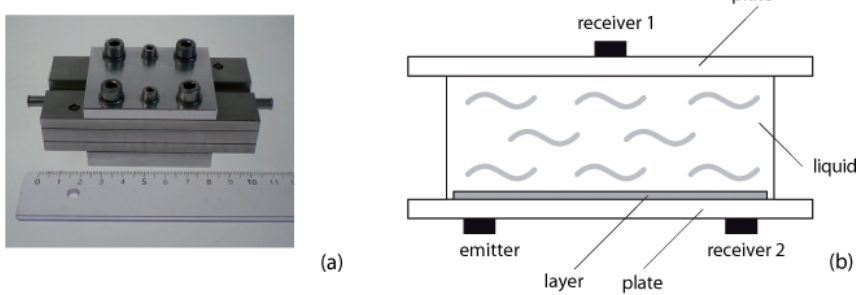
Figure 18. (a) Measurement setup for the container structure consisting of stainless steel. (b) The measurement setup consisting of two parallel plates onto which one emitter and two receivers are